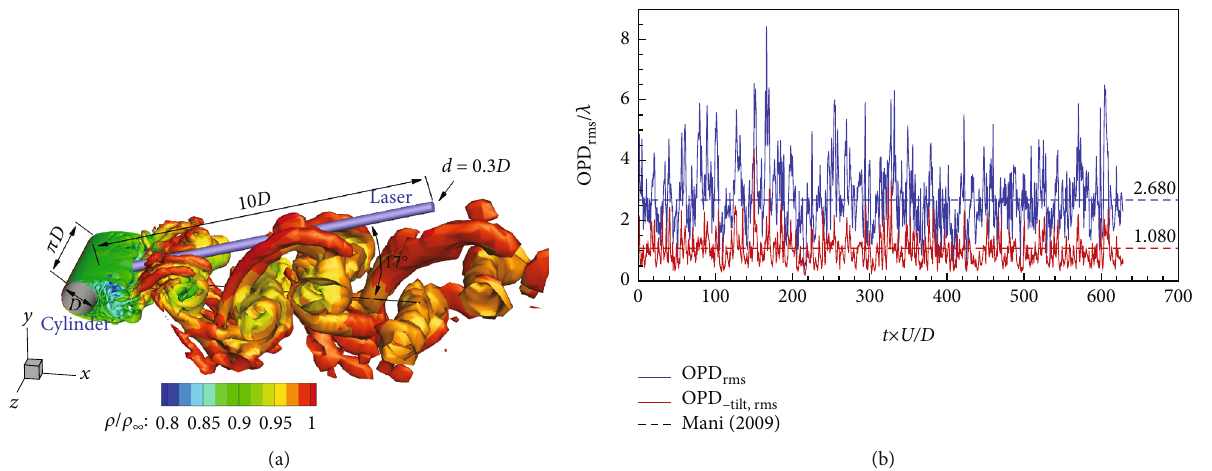
Figure 5: (a) The separated shear layer and the wake behind the cylinder, and (b) beam wavefront distortion. Shock and separation Shear layer